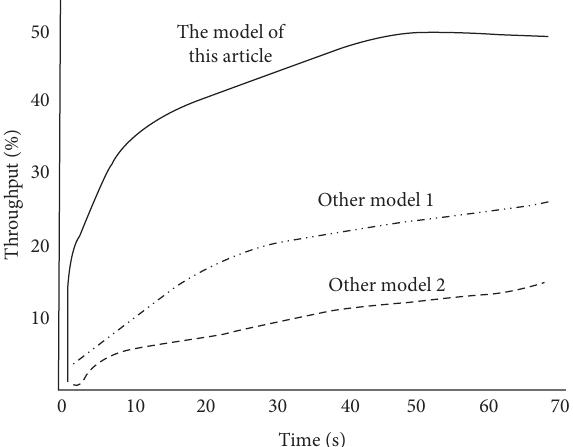
Figure 5: Throughput comparison of different models.